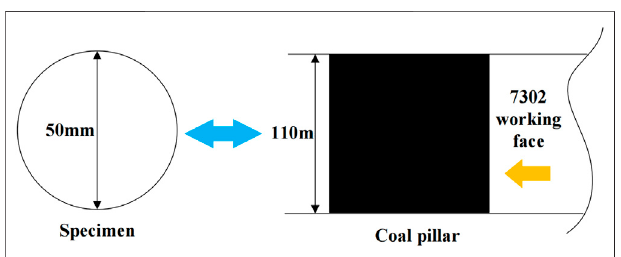
FIGURE 2 | Overview of working face. (A) Working face layout; (B) Borehole of 7302 working face.